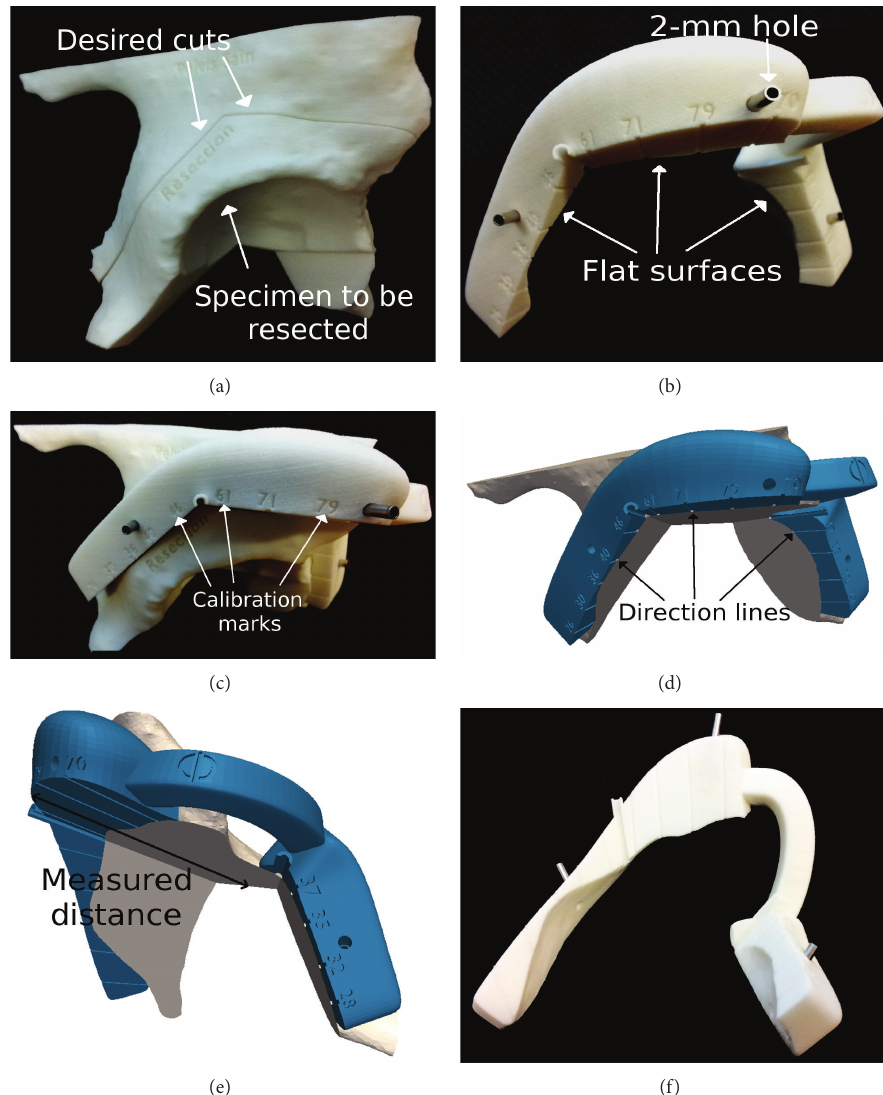
Figure 2: Bone models and PSI produced by additive manufacturing for patient number 6. (a) Bone model of the patient enables the visualization of the desired resection strategy and the tumor specimen to be resected. (b) PSI is equipped with flat surfaces to indicate the desired resection planes, holes to be pinned temporarily on the bone using Kirschner wires. (c) PSI has a position of best fit on the bone model. Calibration marks are engraved on the edge to provide visual control of the cutting depth. (d) Associated with a calibration mark direction lines indicate the depth of cutting. (e) The depth is measured from the outer edge of PSI to the deepest bone structure. (f) The direction lines engraved onto the flat surfaces of